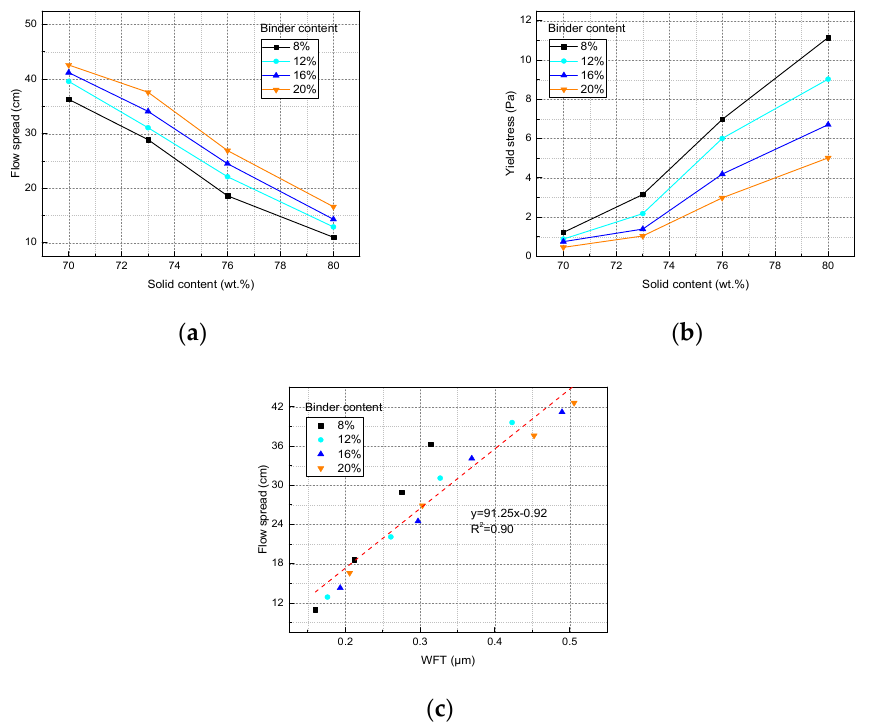
Figure 1. Flowability of CPB slurry. ( a ) Relationship between solid content and flow spread, ( b ) Relationship between solid content and yield stress, ( c ) Relationship between WFT and flow spread. The water film thickness (WFT) of CPB samples are tabulated in Table 5. To better understand how the WFT is related to flow spread, the WFT is plotted versus flow spread in Figure 1c. Generally, from Figure 1c, it can be seen that the flow spread increased with the WFT at almost a constant rate. Regression analysis has been used to study the e ff ect of WFT, deriving a best-fit curve for the flow spread-WFT relation. The straight-line form, coupled with the high R 2 value of 0.9, reveals that the flow spread-WFT relation is generally linear. As has been shown by Zhang et al. [36,37], there are